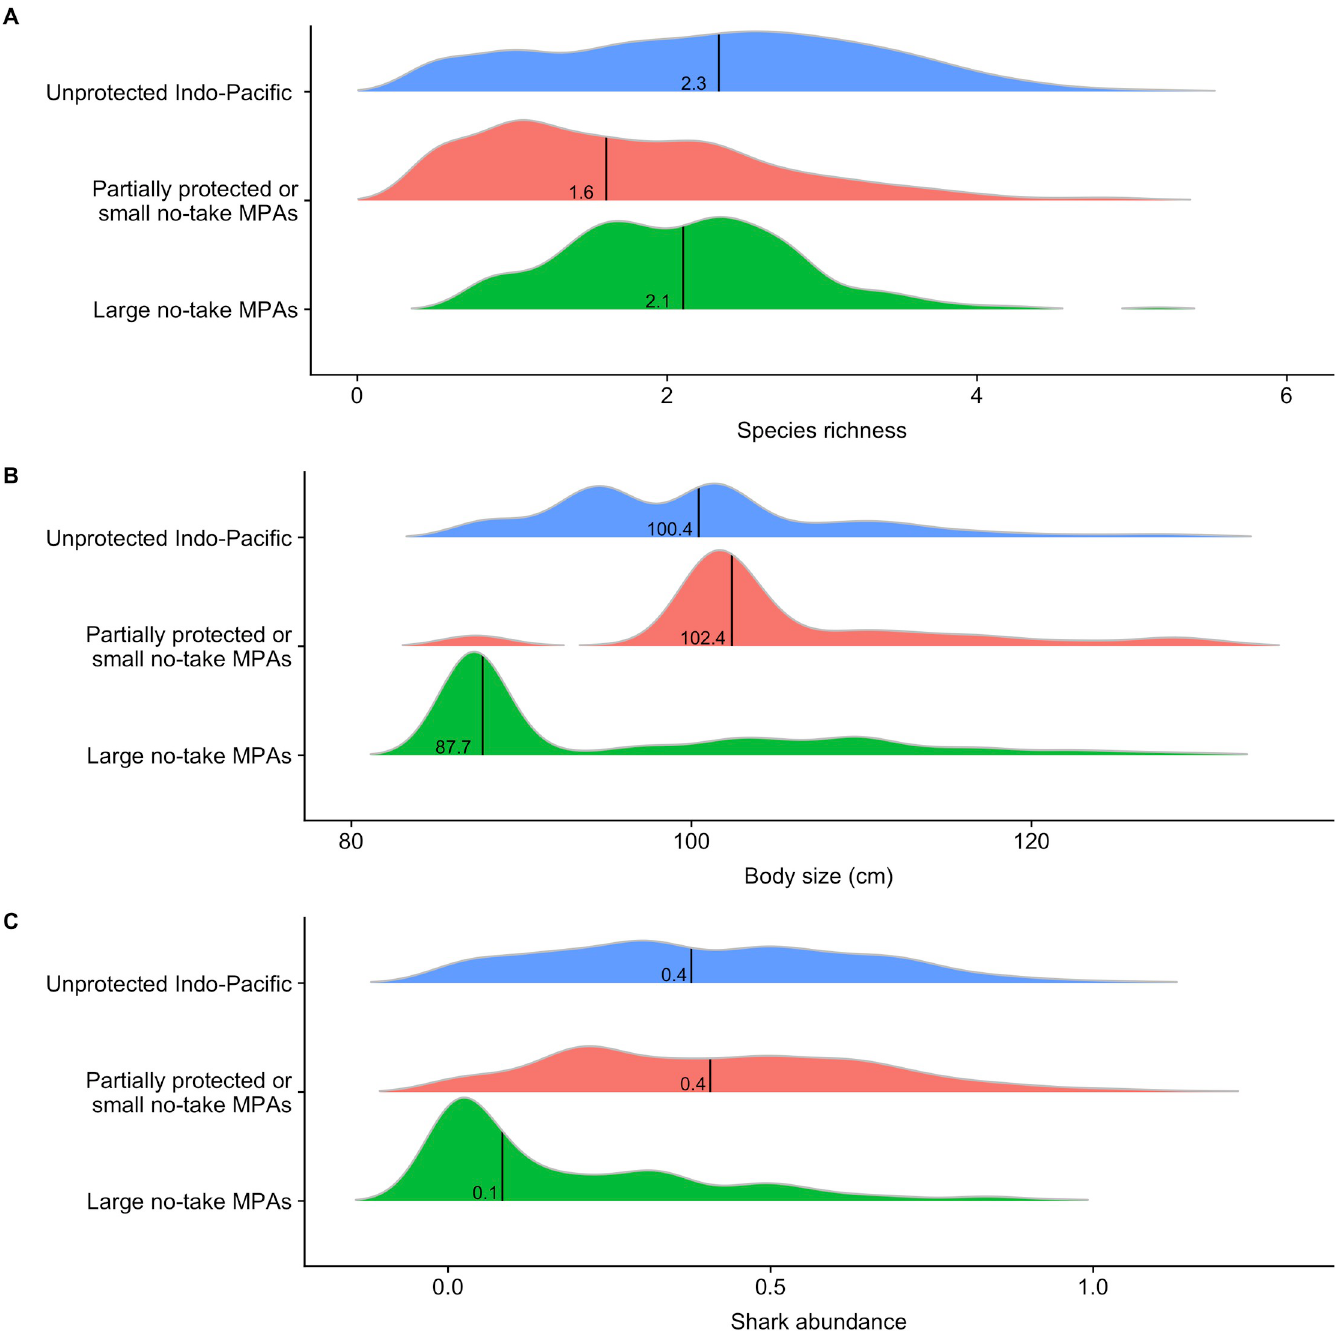
Fig 6. Frequency distributions of predator attribute values predicted to occur under different spatial management regimes in the Indo-Pacific. (A) Vertebrate species richness, (B) body size, and (C) shark abundance (log[sumMax N + 1]) across the entire unprotected Indo-Pacific, inside partially protected or small MPAs and inside large no-take MPAs ( > 1,000 km 2 ). Vertical lines and values are associated medians. MPA, marine protected